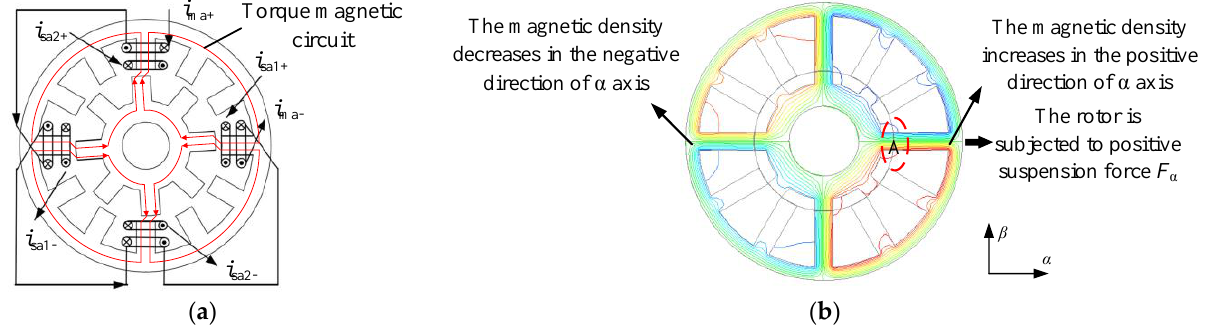
Figure 1. Torque and suspension force generation mechanism: ( a ) Principle of torque generation; ( b ) Mechanism of suspension force generation.